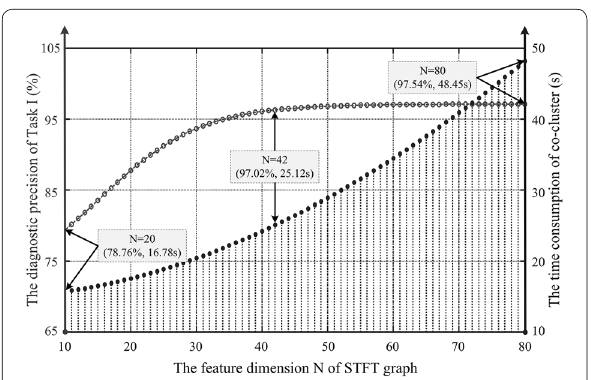
Figure 10 Diagnostic precision and time consumptions of co-clustering model